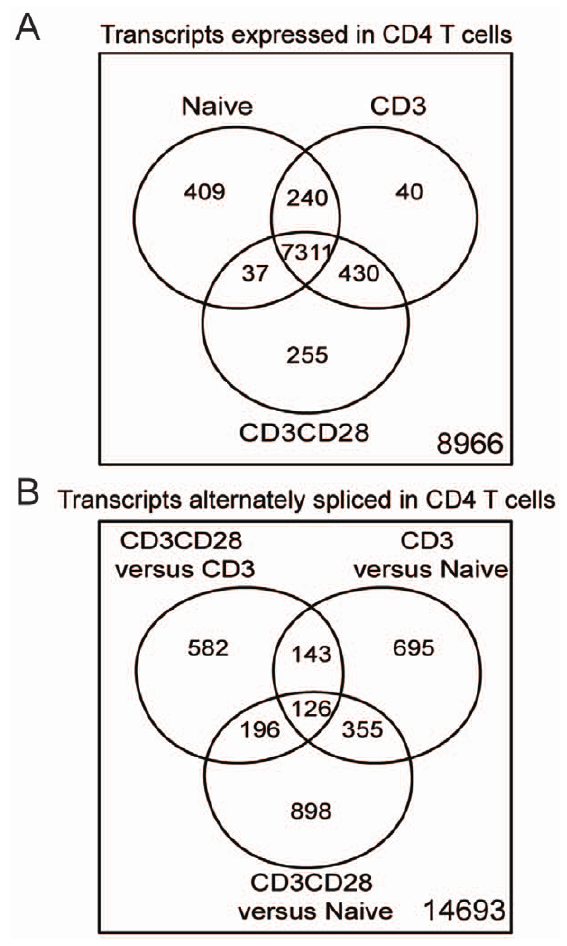
Figure 1. Genes are both differentially expressed and alter- nately spliced following TCR and CD28 activation. (A) Venn diagram showing the number of transcripts expressed in naı¨ve, TCR- activated, and TCR/CD28-activated T cells. The unique transcripts for each group are provided in Table S1. These unique transcripts are enriched for Gene Ontology biological processes, provided in Table S2. (B) Venn diagram showing the number of transcripts differentially spliced in naı¨ve, TCR-activated, and TCR/CD28-activated T cells. The unique transcripts (non-overlapping parts of the Venn diagram) are listed in Table